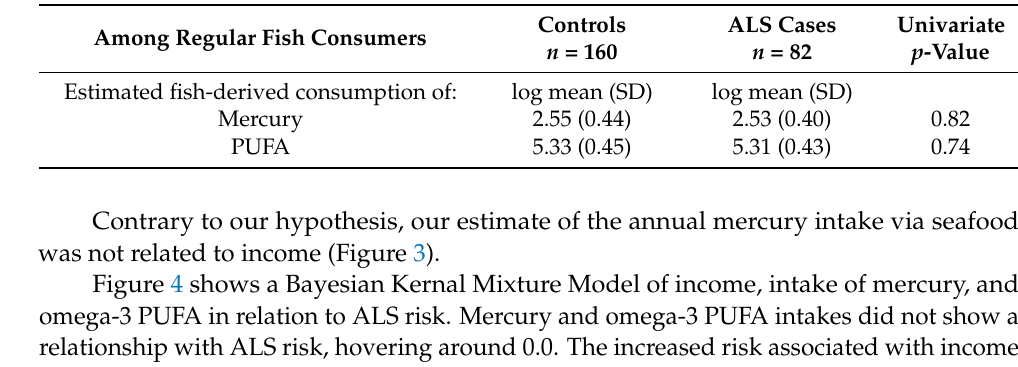
Table 3. Analysis of relationship between fish-derived mercury, PUFA, and ALS risk.